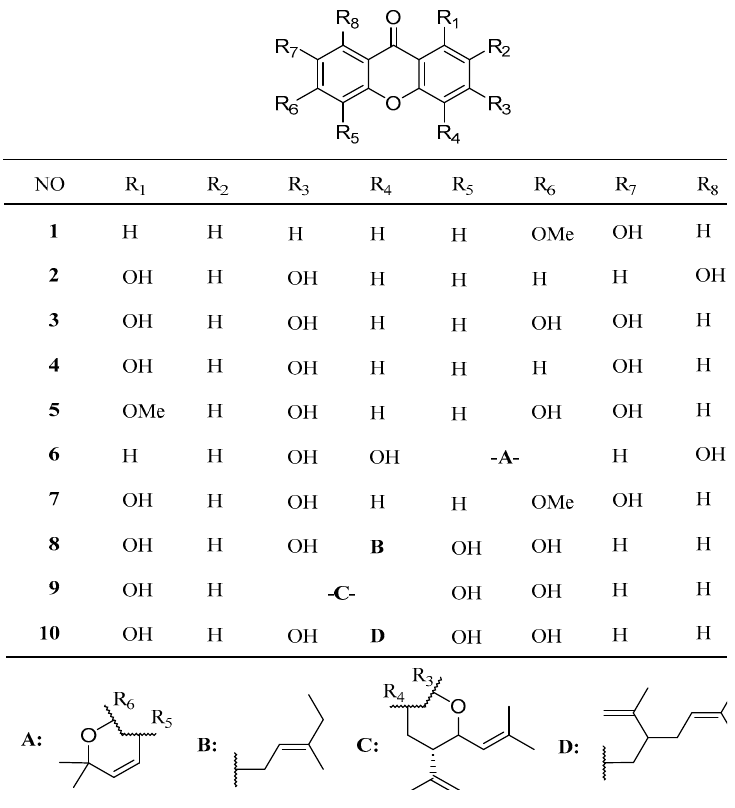
Figure 4. Structures of xanthone derivatives from H. stellatum . Table 2. IC 50 values of xanthones from H.